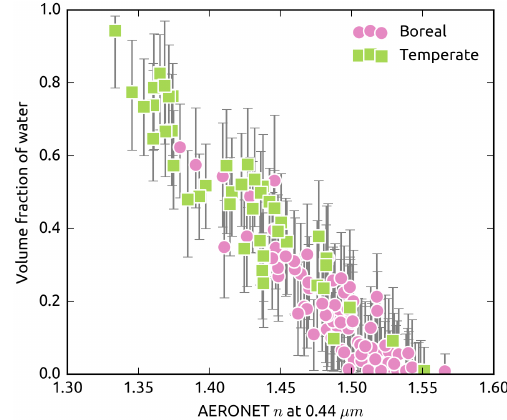
Figure 5. Inferred volume fraction of water. Error bars show in- terquartile range of inferred values resulting from uncertainties in AERONET particle